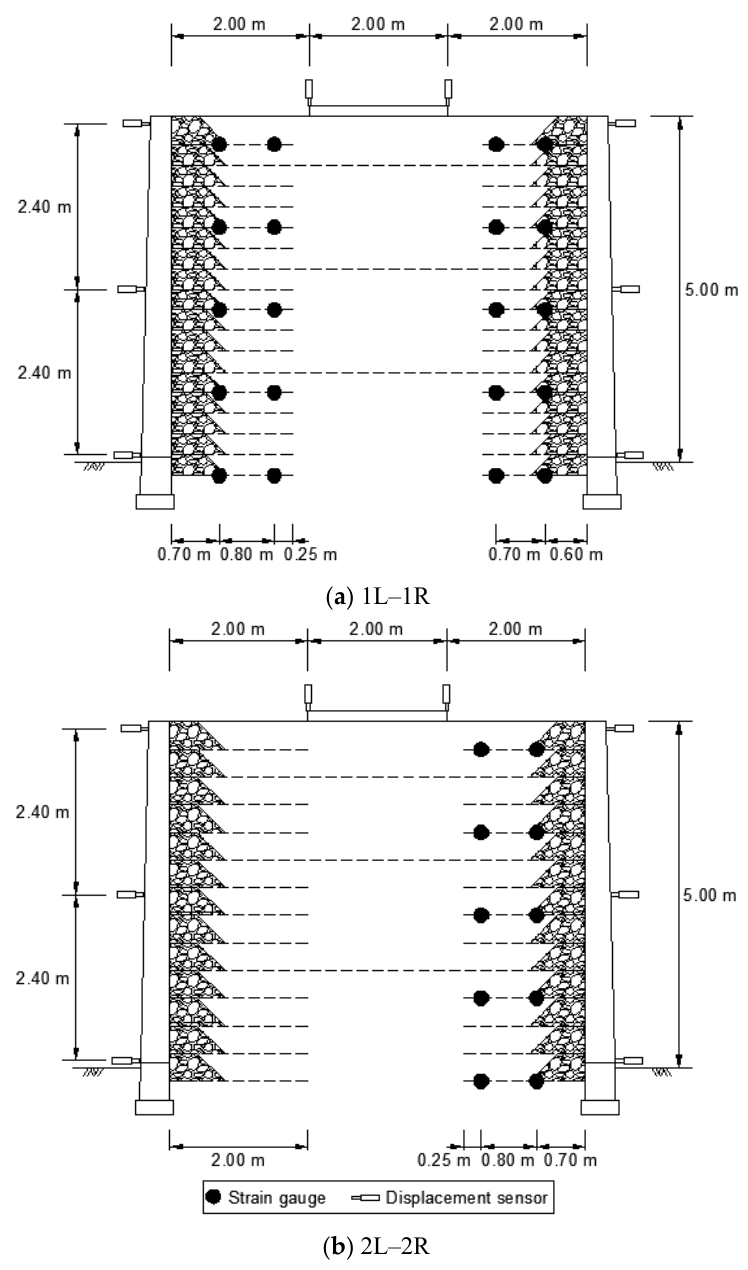
Figure 10. Location of the sensors.